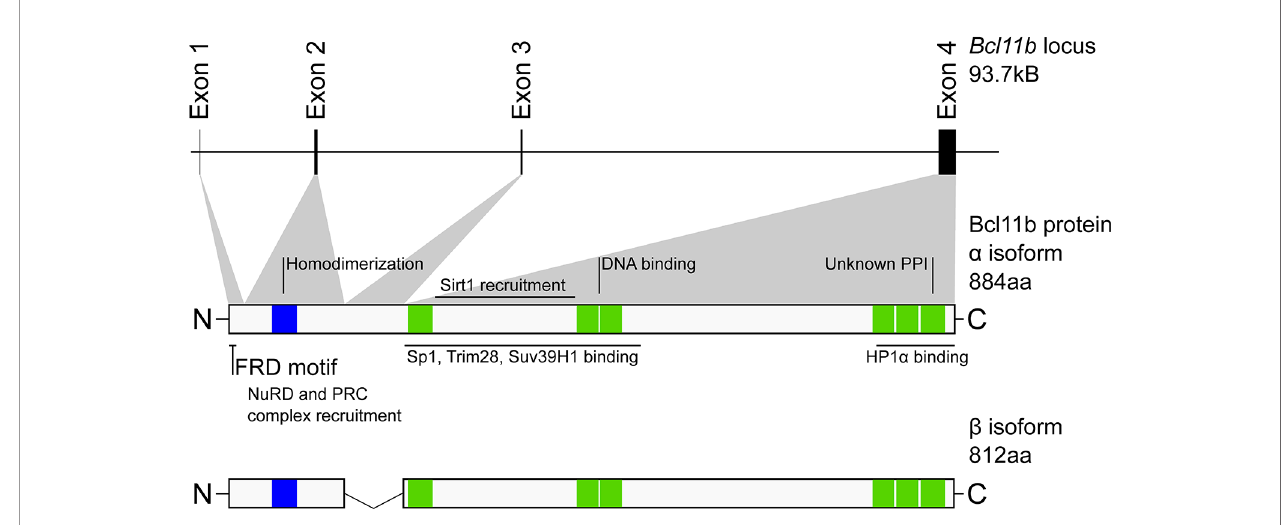
FIGURE 1 | Structure and organization of the murine Bcl11b locus and protein. Scale representation of the distribution of Bcl11b exons (upper) and their contribution to Bcl11b protein primary structure (middle). Indicated against this are regions experimentally determined to be involved in cofactor binding or required for Bcl11b function. Lower, Bcl11b b isoform. Not shown is the g isoform (formed from exons 1 and 4) which is predominantly identi fi ed in transformed cells. Blue –